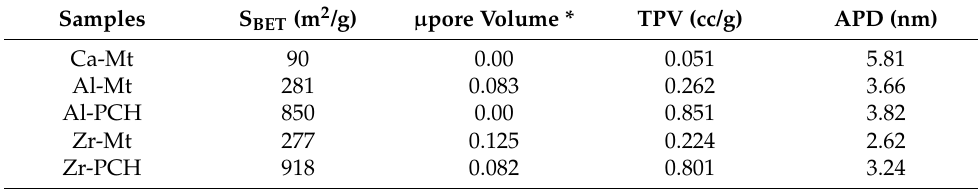
Table 2. Specific surface areas (S BET ), total pore volume (TPV) and average pore diameter (APD) of the starting clay and derived